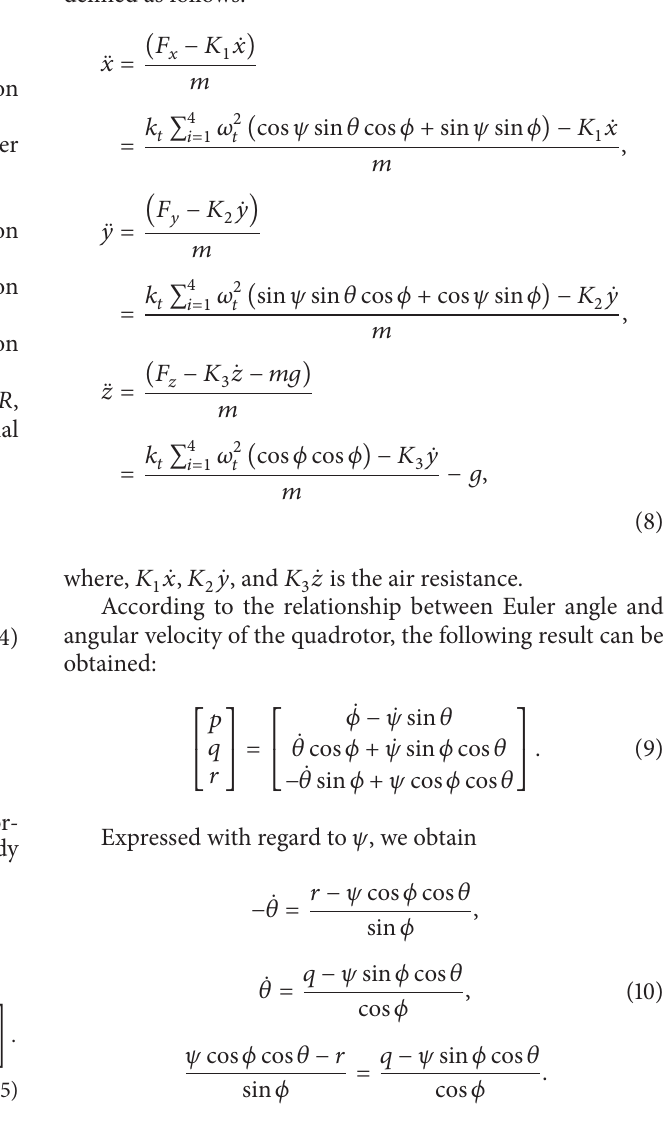
Figure 6: Block diagram of the PID feedback.